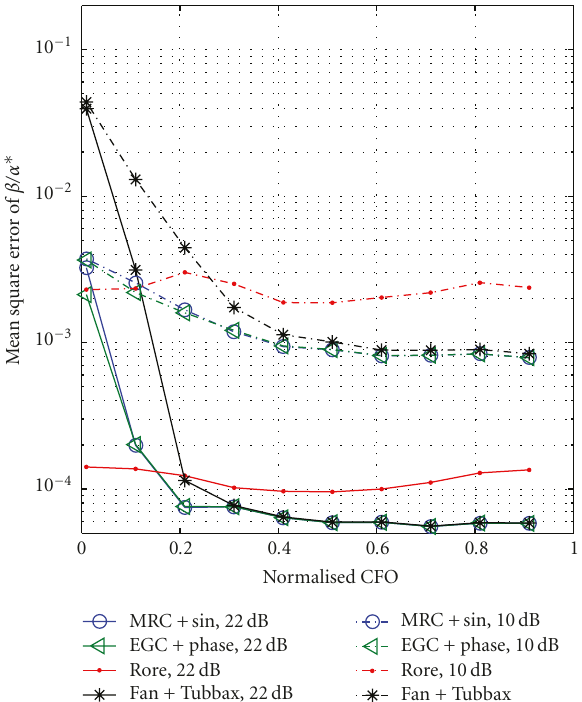
Figure 4: MSE of CFO estimates at SNR = 22 dB in the presence of 2dB gain mismatch and 5 ◦ phase mismatch. Figure 5: MSE of β/α ∗ at SNR